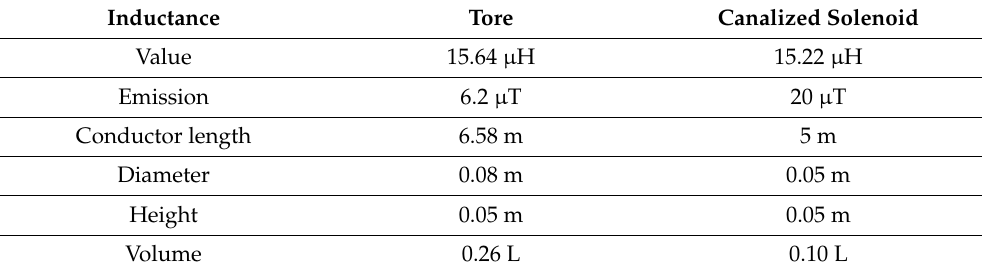
Table 2. Comparison between tore and canalized